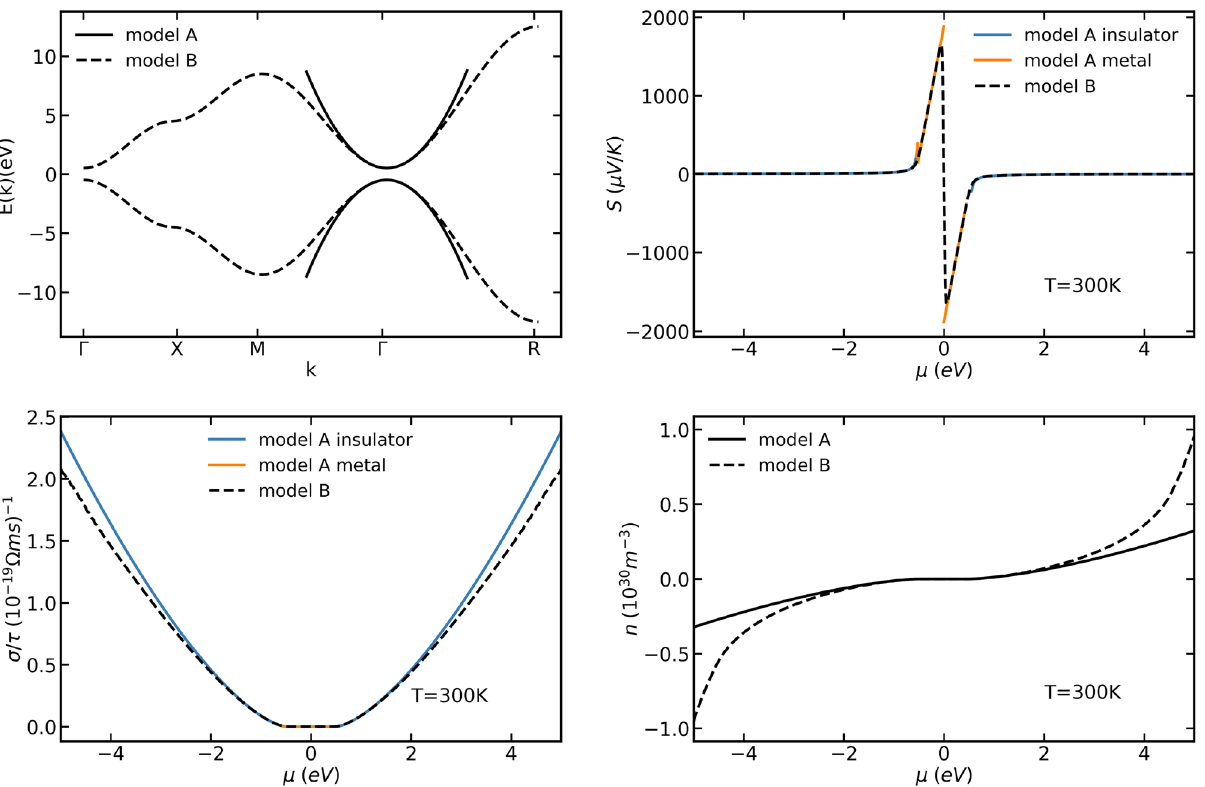
Figure 1. Band-structure of a cubium with two bands (top left panel, dashed line) and a parabolic fit near Ŵ point (solid line). In the top right, bottom left, and bottom right panels, the Seebeck coefficient, the conductivity, and the carrier concentration, respectively, are